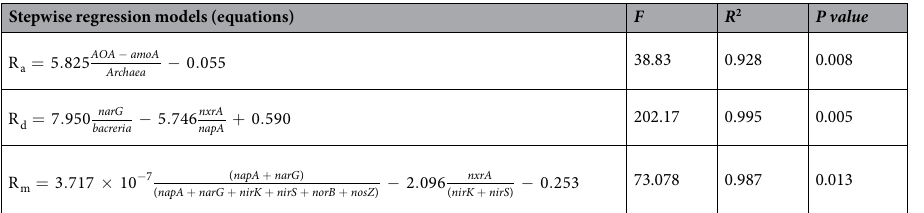
Table 2. Quantitative response relationships between net N transformation rates (mg N kg − 1 d − 1 ) and functional gene abundance (copies g − 1 ) during the process of artificial vegetation